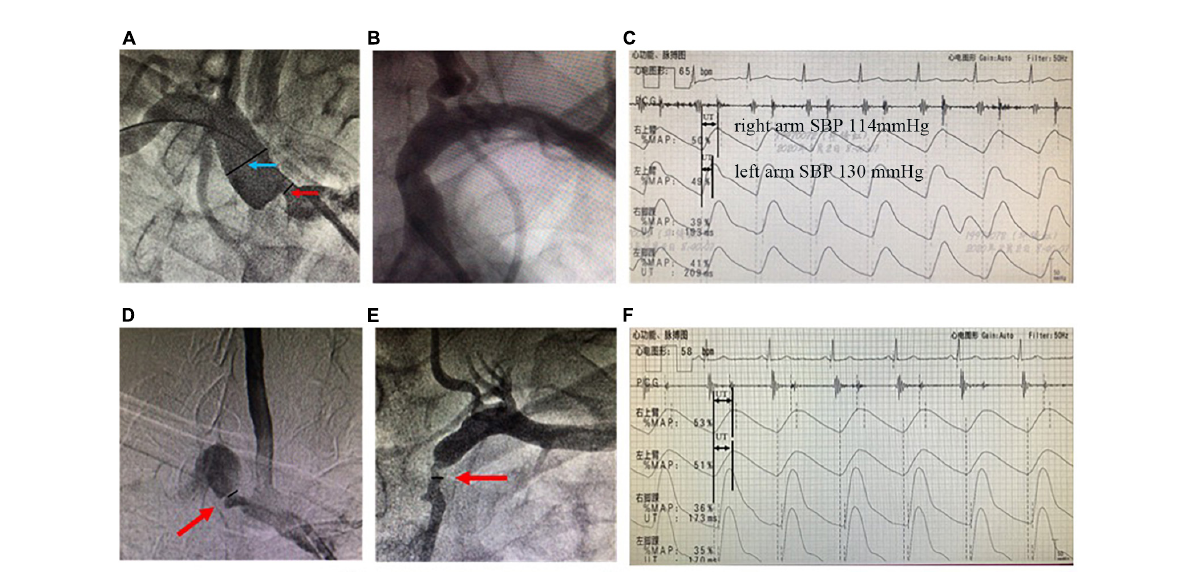
FIGURE2 Angiographies of SAS and recordings of simultaneous extremity blood pressure and PVR. The upper panels are from a representative unilateral SAS case. (A) Arteriography showed the stenotic severity of the proximal lumen of the right subclavian artery. The degree of stenosis was 71.4% (the diameter of the narrowest lumen in the red arrow/the reference diameter of the distal lumen in the blue arrow; (B) the lumen of the left subclavian artery was normal; (C) The simultaneous extremity blood pressure measurement showed inter-arm systolic blood pressure difference = 16 mmHg (right arm systolic pressure 114 mmHg, left arm systolic pressure 130 mmHg). And PVR showed that the peak of the right arm was delayed significantly more than that of the left arm. The UT and UTCC were 260 ms and 28.2%, respectively. While the left arm UT and UTCC were 184 ms and 19.9%, respectively. The lower panels are from a bilateral SAS case. (D) Arteriography shows right SAS of 76.4%; (E) left SAS of 69.1%; (F) the UT of the left and right arms are 309 and 322 ms, and the UTCC is 29.9 and 31.1%, respectively. SAS, subclavian artery stenosis; IASBPD, inter-arm systolic blood pressure difference; please see previous figures or tables for other abbreviations.